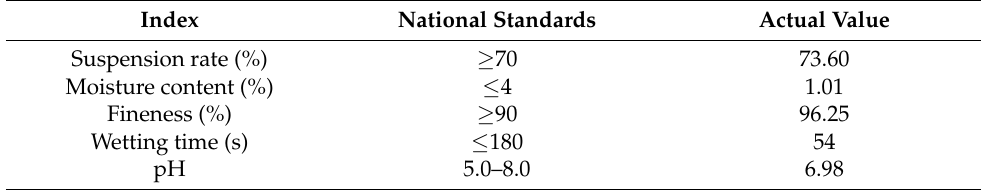
Table 2. Values for quality inspection of wettable powder of B. subtilis XZ18-3.